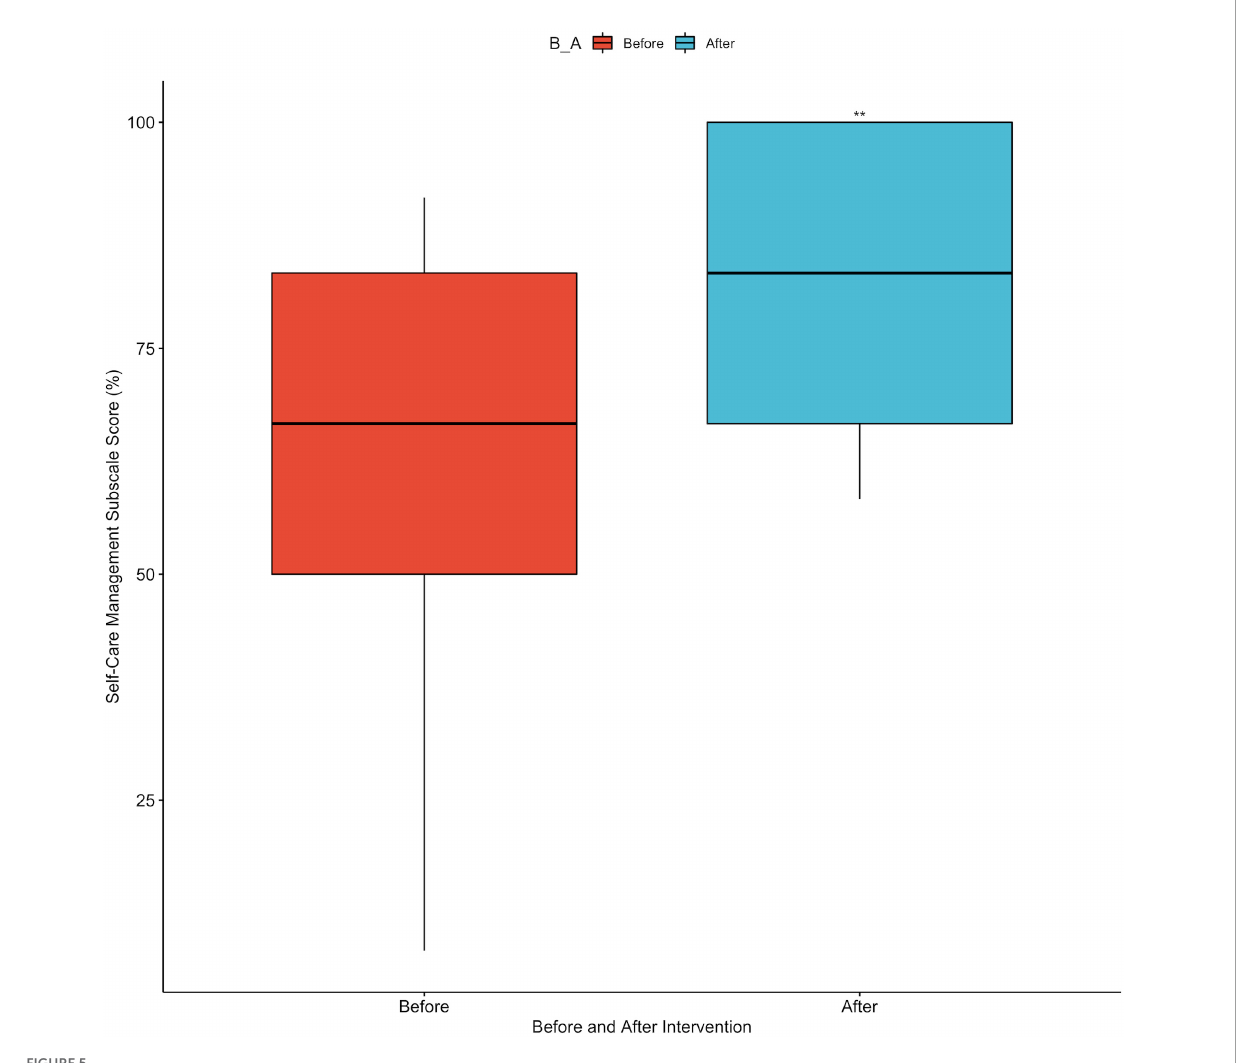
FIGURE5 Boxplot of Self-Care Management subscale scores before and after intervention. **Indicates statistically significant difference, p < 0.008.